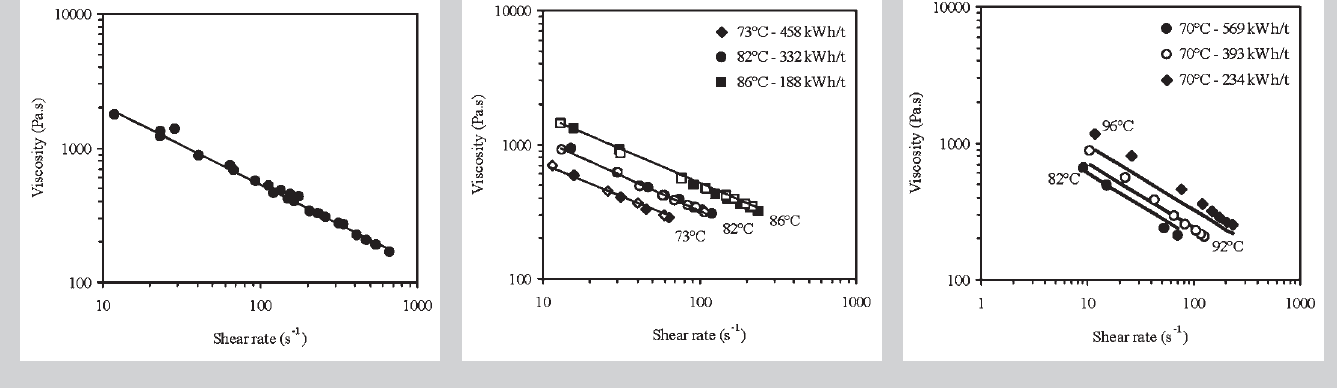
Figure 9 (left): Mastercurve of viscosity, for three different water con- tents, after rescaling at 90°C and 200 kWh/t. Figure 10 (middle): Comparison of viscosities for products extruded in the same conditions, without (full symbols) and with (open symbols) cationiza- tion reaction. Temperatures indicated on the curves are die exit temperatures for starch without and with reaction. Figure 11 (right): Comparison of viscosities calculated from Eq. 8 (full lines) and measured with slit die (symbols) for prod- ucts extruded with the screw profile 2. Tempera- tures indicated on the curves are die exit tempera-